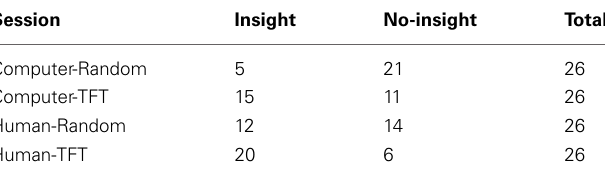
Table 1 | Results of behavioral analyses. A. Distribution of subjects with and without